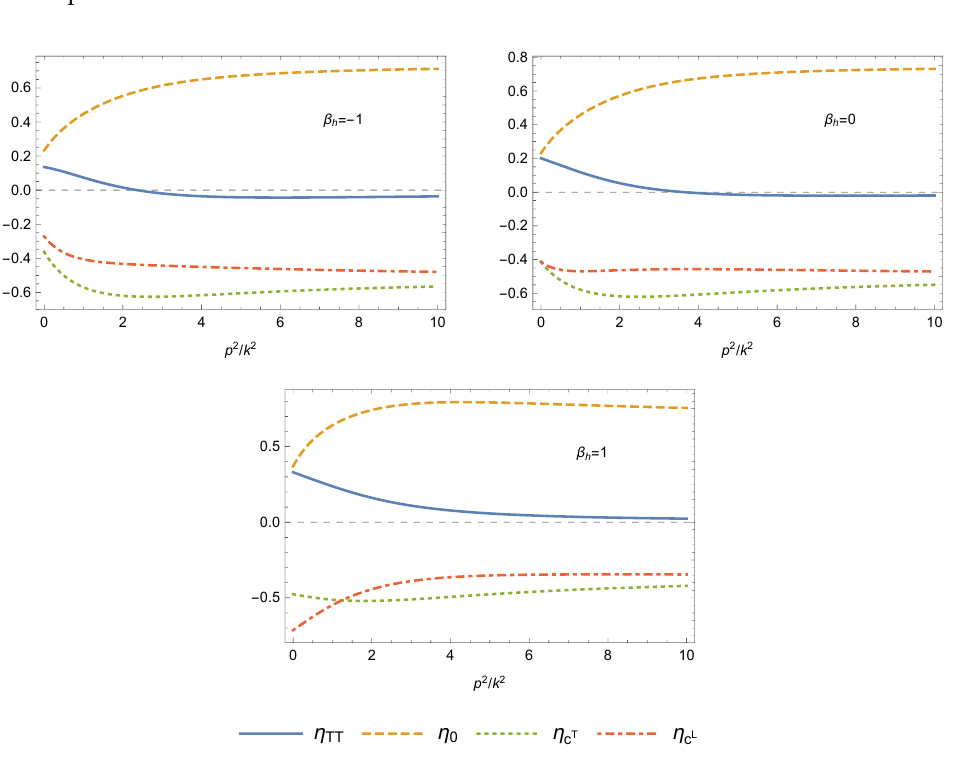
Figure 5. Gauge dependence of the dynamical anomalous dimensions for the choices d = 4, g = 1, µ TL = 0, µ 0 = 0 and the regulator (83). For clarity, we have reinstated k in the momentum